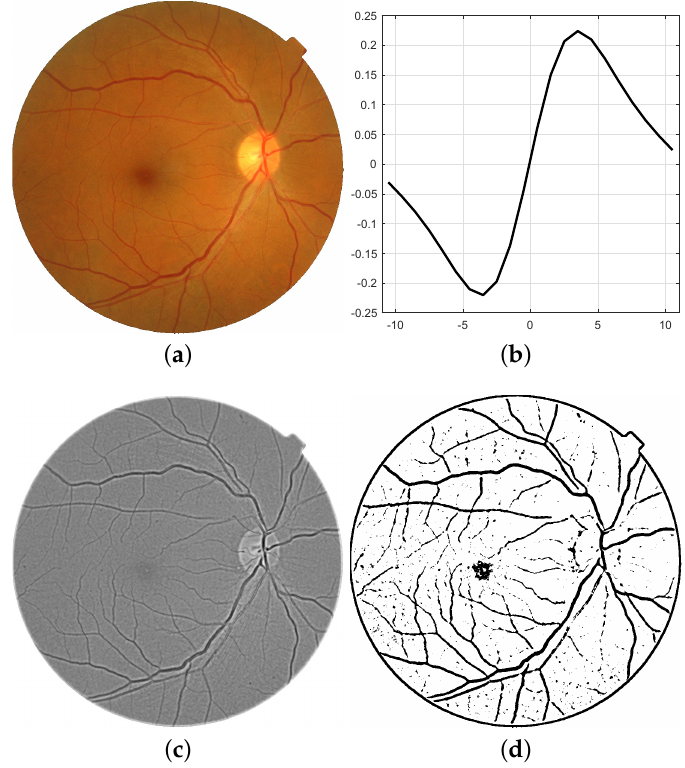
Figure 10. Microaneurysms and hemorrhages detection: ( a ) original image; ( b ) FOGF tuned to detect microaneurysms ( D 0.98 x N x ( 0,2.72 ) ∀ x ∈ [ − 10.5,10.5 ] , k = 22); ( c ) retinal image response from an FOGF; and ( d ) microaneurysms, hemorrhages, fovea, and blood vessels detected (binary output